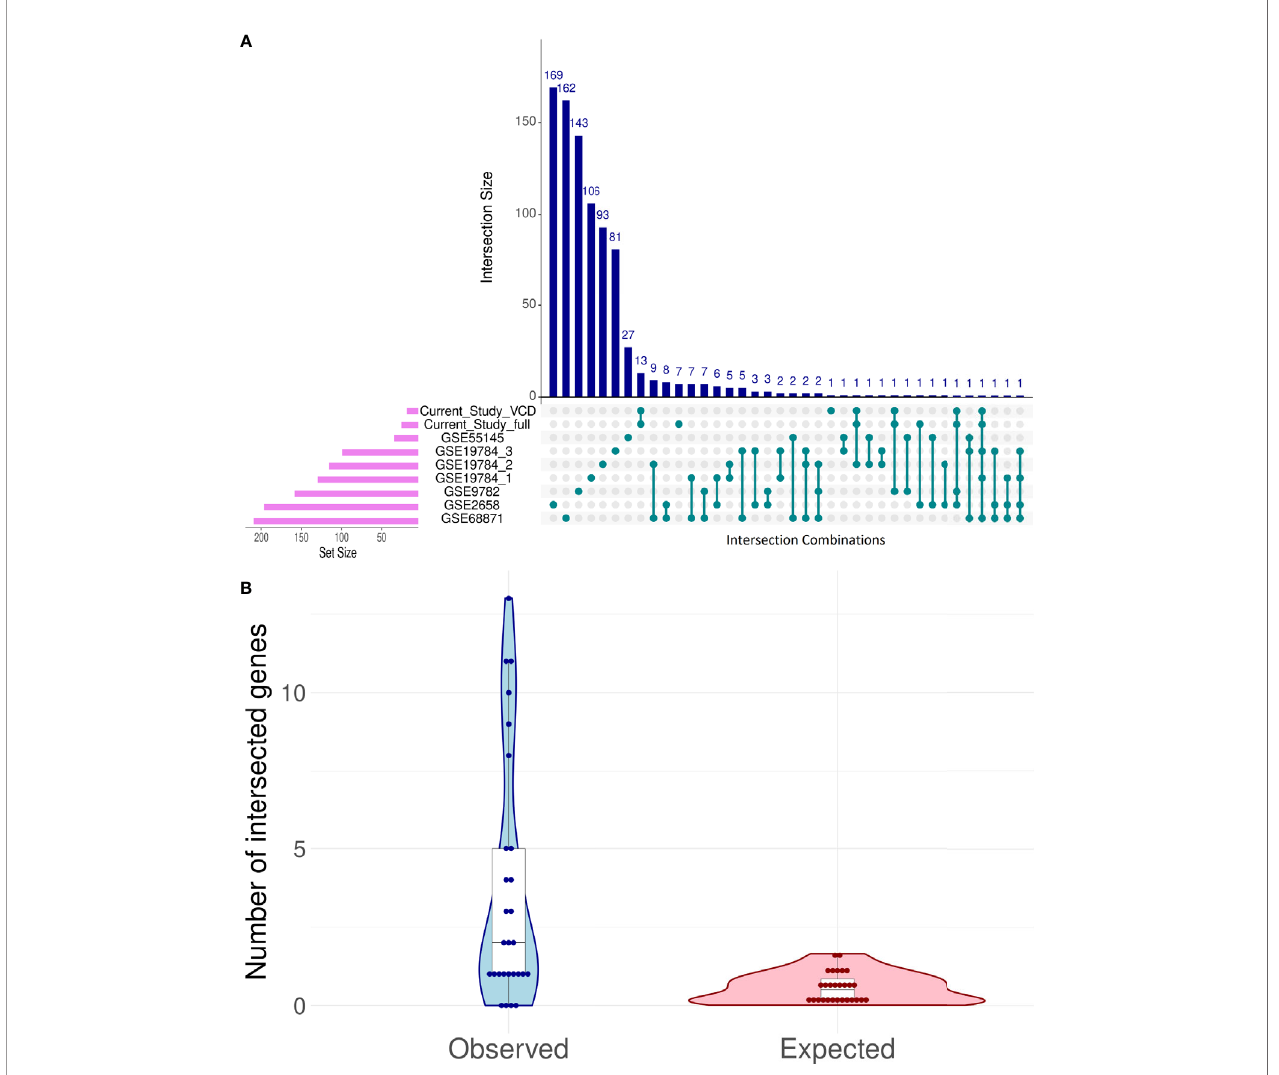
FIGURE 7 | Intersection analysis for differentially expressed genes (DEG) distinguishing good and poor treatment responders in eight bortezomib MM datasets (A) . Observed vs expected (under the hypothesis of random DEG distribution) numbers of intersection events in all possible pairwise comparisons (B) .